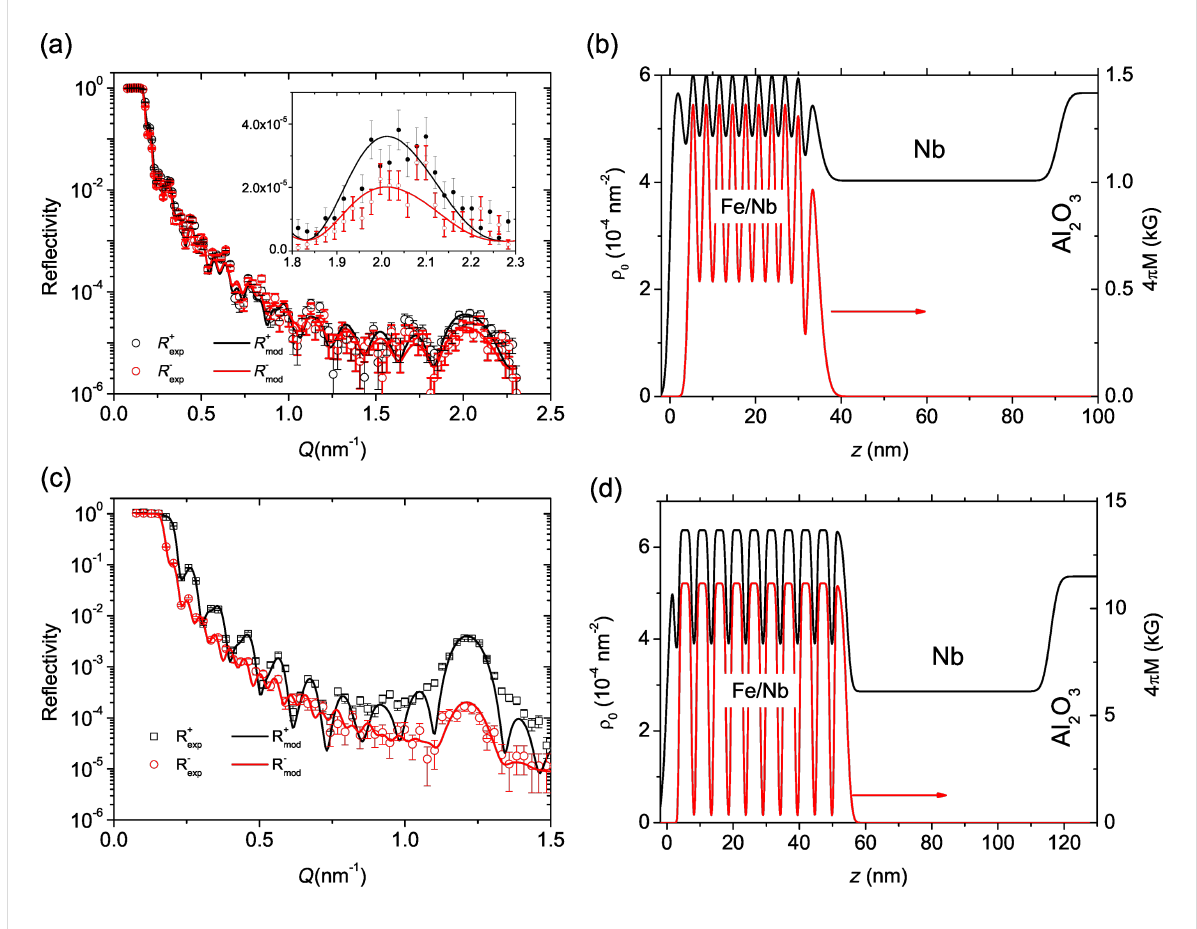
Figure 5: (a) Experimental (dots) and model (lines) reflectivity curves measured on sample s3 at T = 13 K and H = 4.5 kOe. (b) The depth profiles of SLD and magnetization for the same sample. (c) Reflectivity curves for sample s4 measured at T = 300 K and H = 5 Oe. (d) Corresponding depth profile of SLD and magnetization for sample